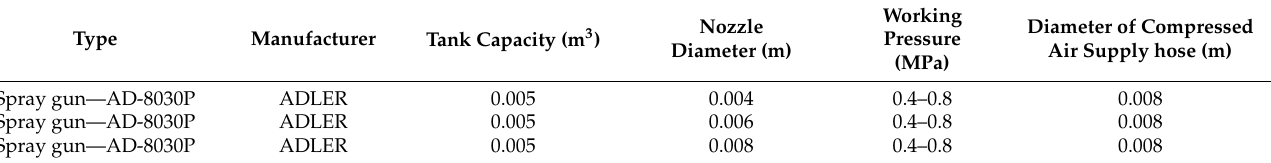
Table 2. Technical specifications of the spray gun.